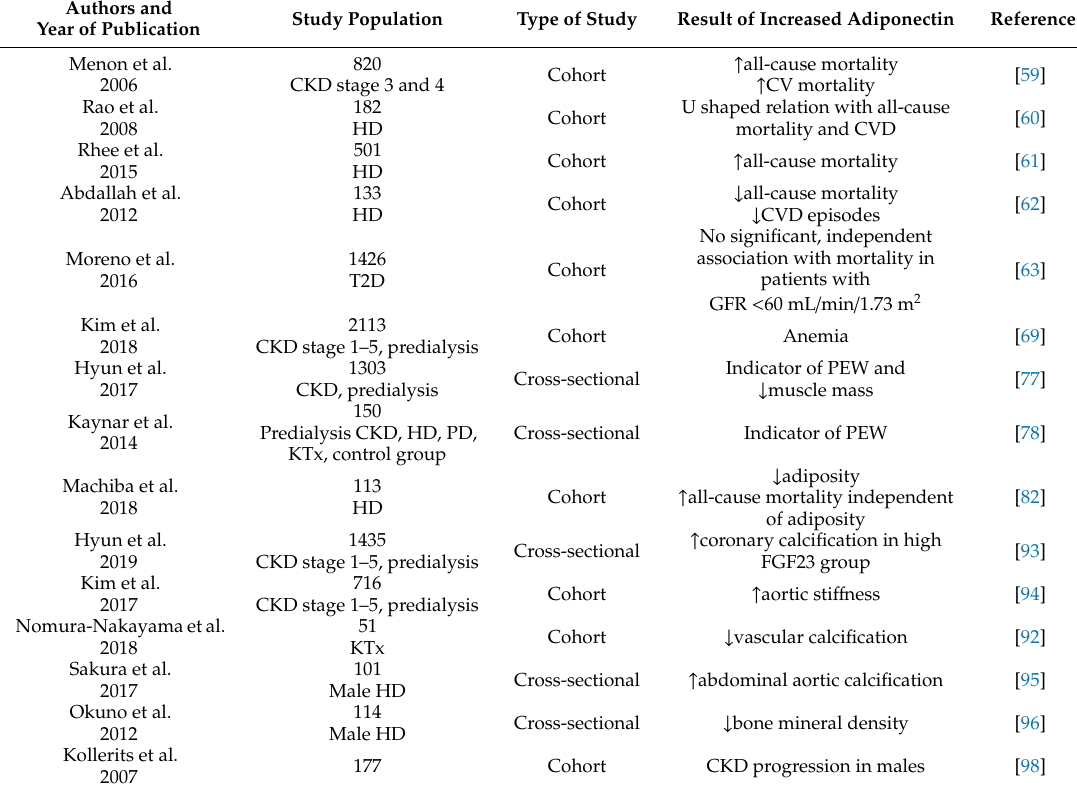
Table 1. Selected studies of adiponectin’s role in chronic kidney